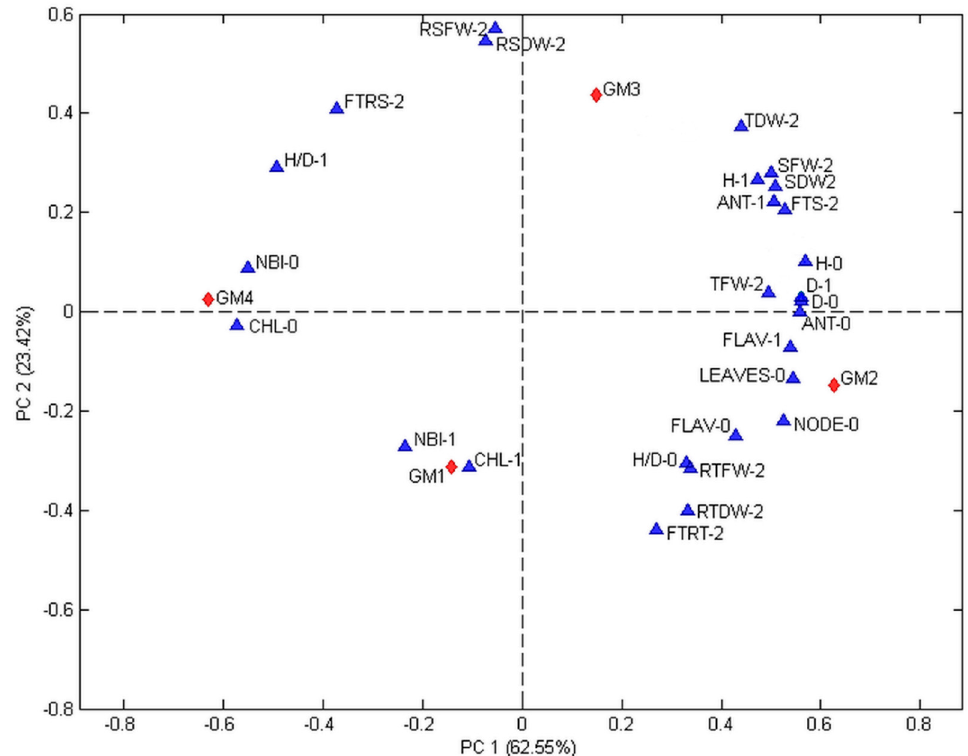
Figure 4. Ordination biplots of principal component analysis outputs of the data from bare-rooted vines grown on growing media (GM) containing biochar (BC) at different rates. GM1 = commercial peat (CP) 100%; GM2 = CP 90% + BC 10%; GM3 = CP 80% + BC 20%; GM4 = CP 60% + BC 40%. Labels in the triangles indicate the investigated parameters: Leaf chlorophyll content (CHL); leaf flavonoid content (FLAV); nitrogen balance index (NBI); leaf anthocyanins (ANT); plant height (H); height diameter ratio (H/D); shoot fresh weight (SFW); rootstock fresh weight (RSFW); root fresh weight (RTFW); total fresh weight (TFW); shoot dry weight (SDW); rootstock dry weight (RSDW); root dry weight (RTDW); total dry weight (TDW); fraction to shoot (FTS); fraction to rootstock (FTRS); fraction to root (FTRT). 0 = parameter recorded at 170 day of year (DOY); 1 = parameter recorded at 275 DOY; 2 = parameter recorded at 362 DOY.